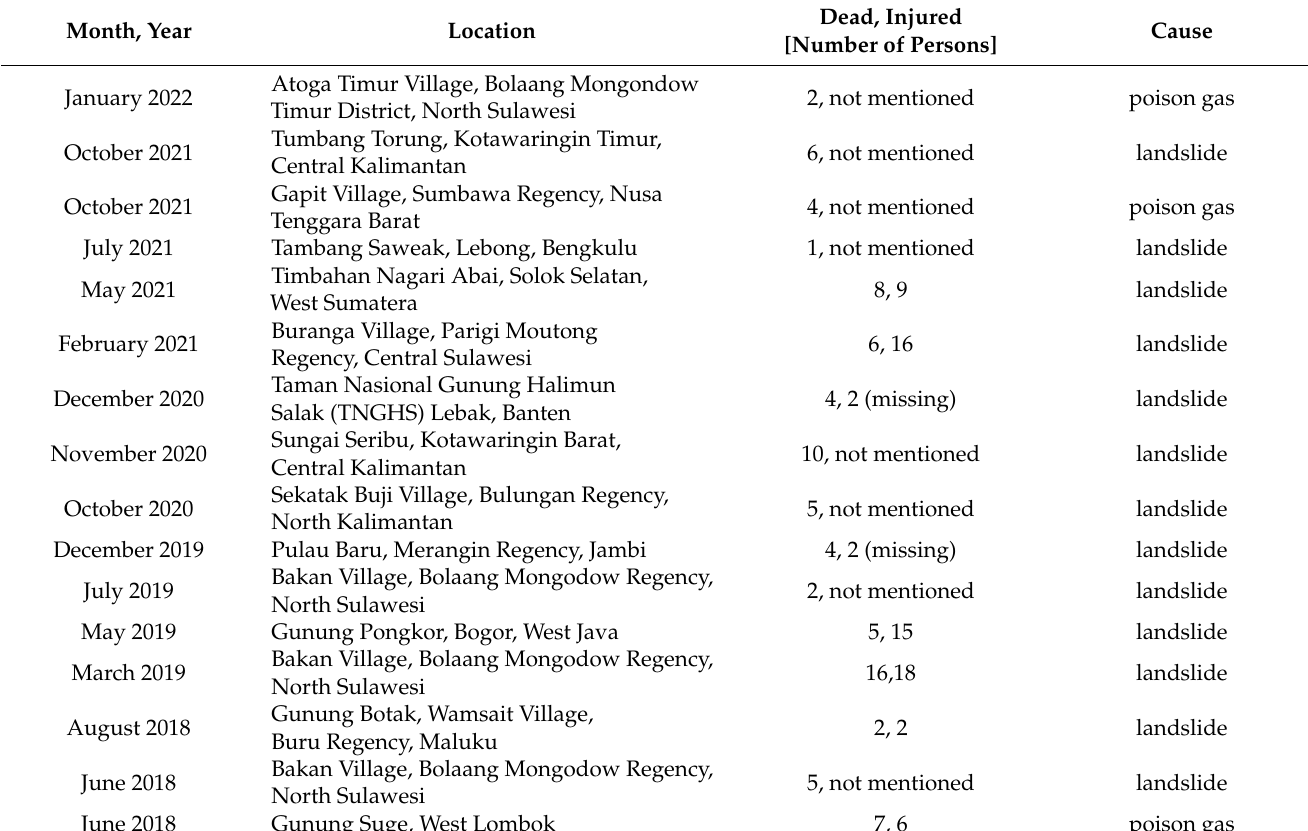
Table 5. Victims of illegal mining over the last 5 years (Source: online news).